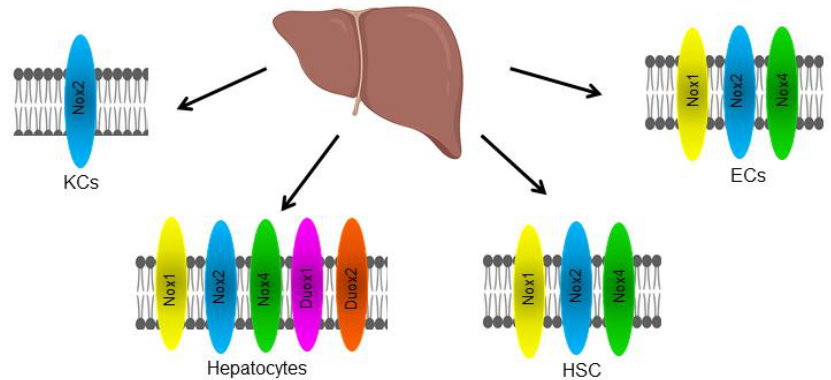
Figure 2. Cellular distribution of isoforms of the NOX family in the liver. Liver cells, such as hepatocytes, Kupffer cells (KCs), endothelial cells (ECs), and hepatic stellate cells (HSCs), express different NOX isoforms.